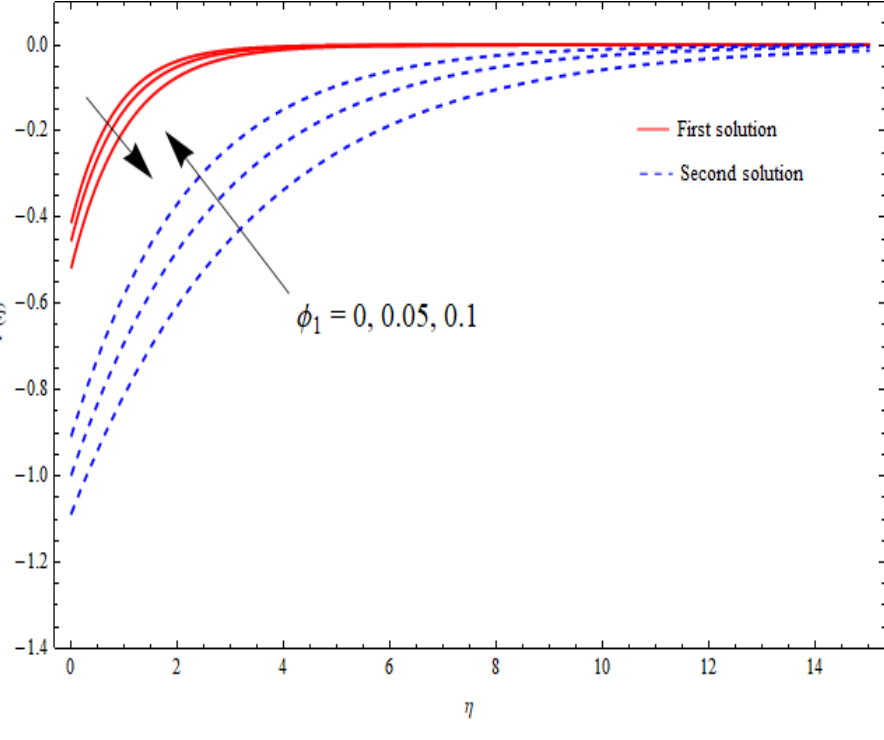
Figure 7. Velocity profiles f (cid:48) ( η ) for distinct ϕ 1 when λ = − 1.5, s = K = γ = 1, δ = − 1, φ 2 =